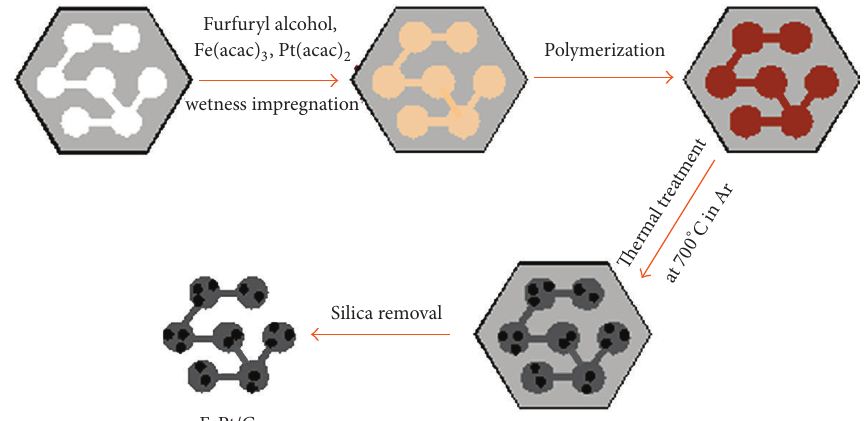
F 1: Schematic procedures for the synthesis of magnetic mesoporous FePt/C composites.